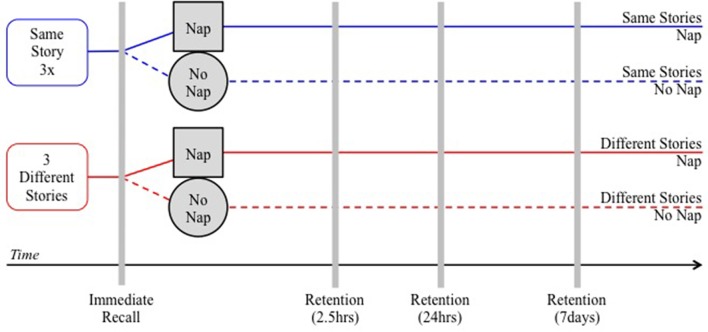
Schematic of the design in Williams and Horst (2014).